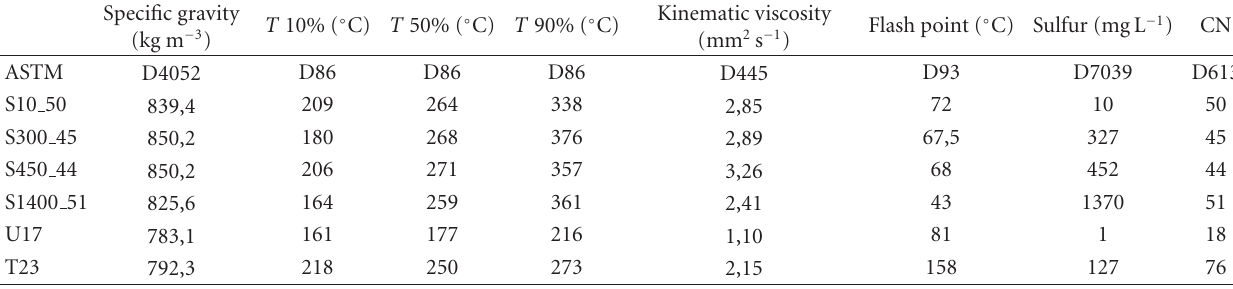
Table 1: Physicochemical properties of fuels and secondary standards.